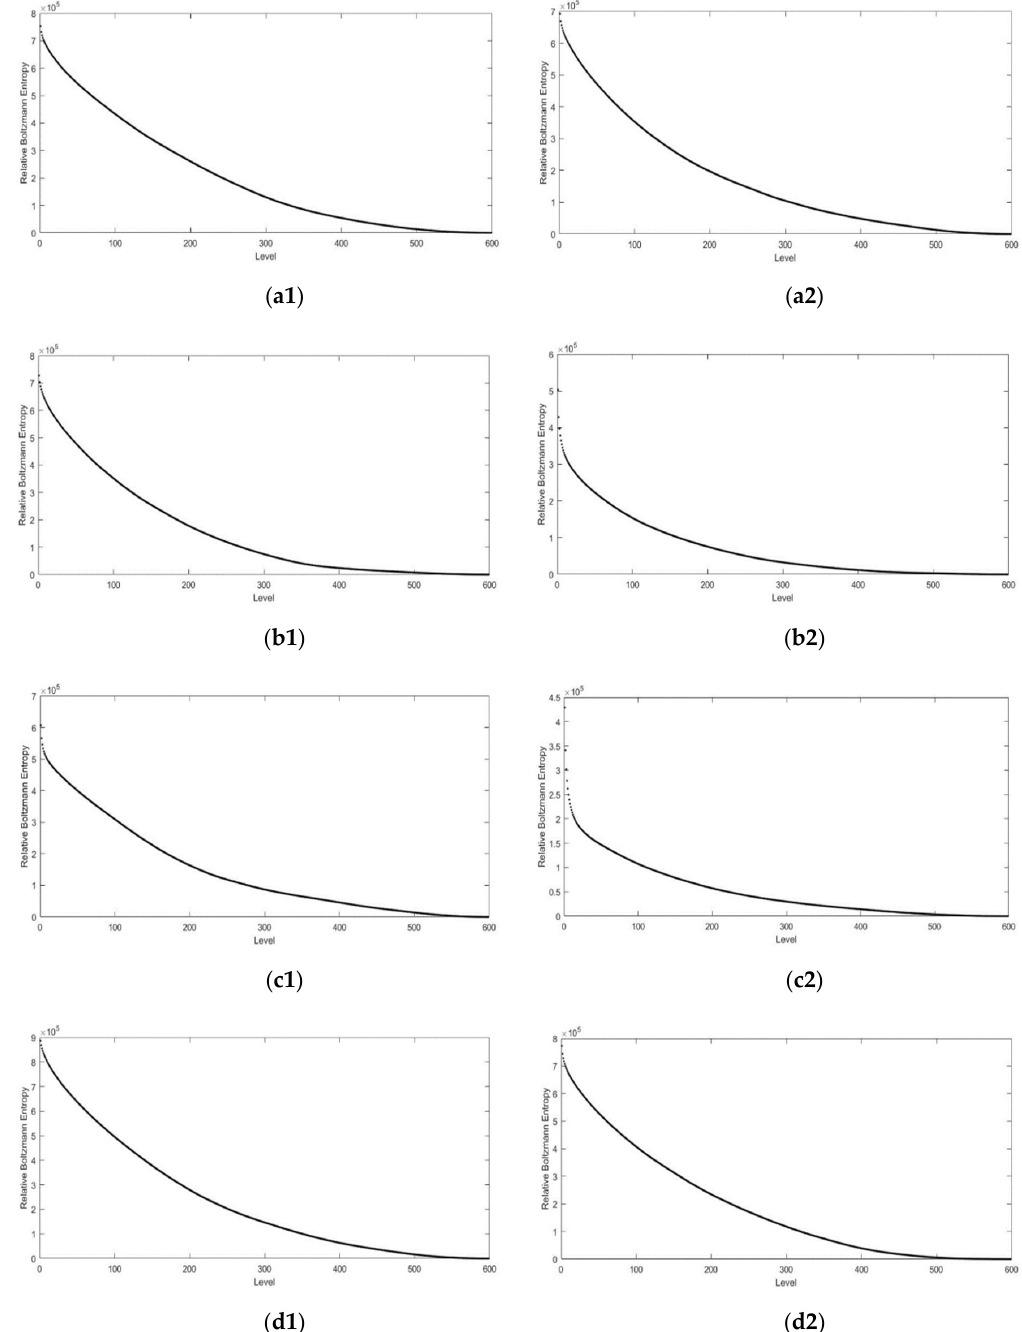
Figure 9. Plots of level against relative Boltzmann entropy for each of the eight DEMs. ( a1 – b1 ), ( c1 ) and ( d1 – d2 ) Six plots of level against relative Boltzmann entropy for DEMs with high heterogeneity; ( b2 ) and ( c2 ) Two plots of level against relative Boltzmann entropy for DEMs with low heterogeneity. The negative slopes of DEM b2 and DEM c2 are steeper than those of the other DEMs. From Figure 6, it is clear that DEM b2 and DEM c2 began with smoother topography than the other DEMs, indicating low heterogeneity. This may be exacerbated by the process of reducing the resolution through the resampling technique, which tends to decrease heterogeneity even further for those images with lower heterogeneity. In other words, with the decrease of spatial heterogeneity, the abundance of impossible microstates diminishes, which led the relative Boltzmann entropy of each level to